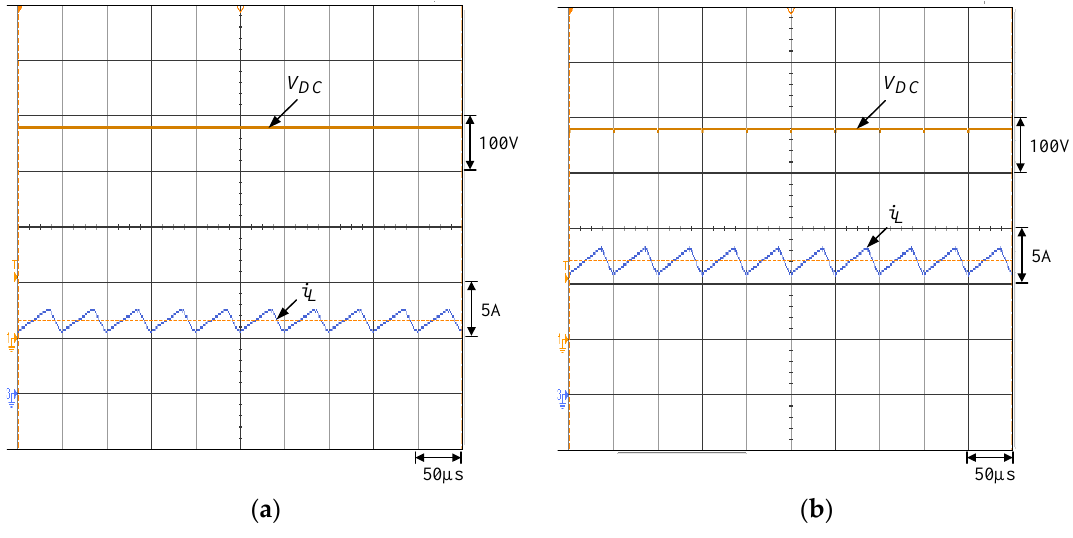
Figure 5. Inductance current and DC-link voltage at constant load: ( a ) 250 Ù (577.6 W); ( b ) 135.7 Ù (1.06 kW).